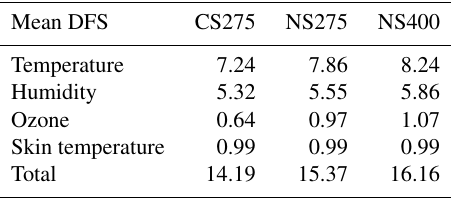
Table 3. Mean of degrees of freedom over 6123 profiles for temper- ature, humidity, ozone and skin temperature for the three channel